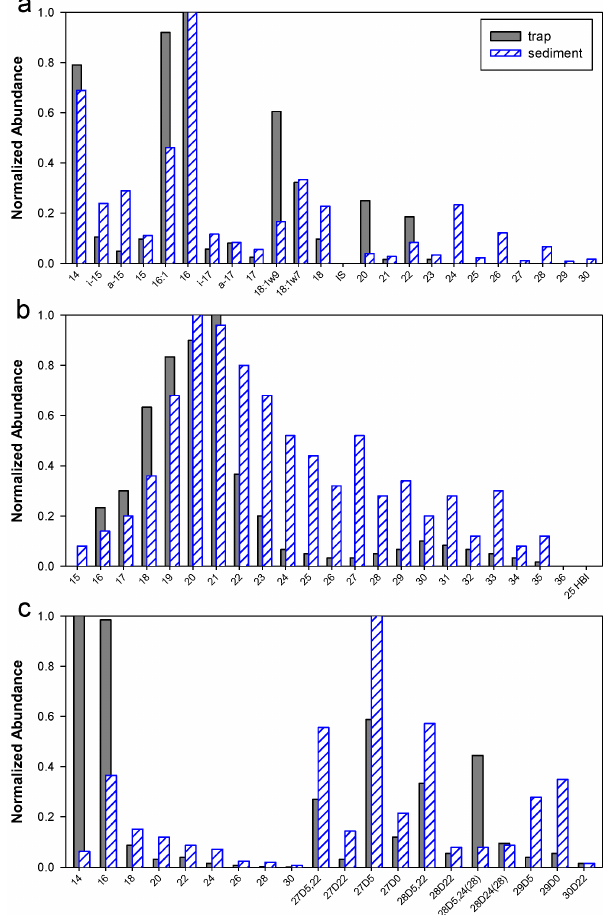
Figure 6. Histograms of relative abundances of (a) fatty acids, (b) hydrocarbons and (c) sterols/alcohols in POM and SOM from the Arabian Sea. Carbon numbers are given for fatty acids, alkanes and alcohols; sterol abbreviations are 27D5,22 = 27 (cid:49) 5 , 22 , etc.